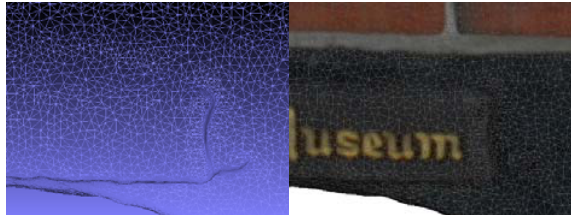
Figure 12. Detail view of the 3D model of the town house, without texture (left) and with texture (right)